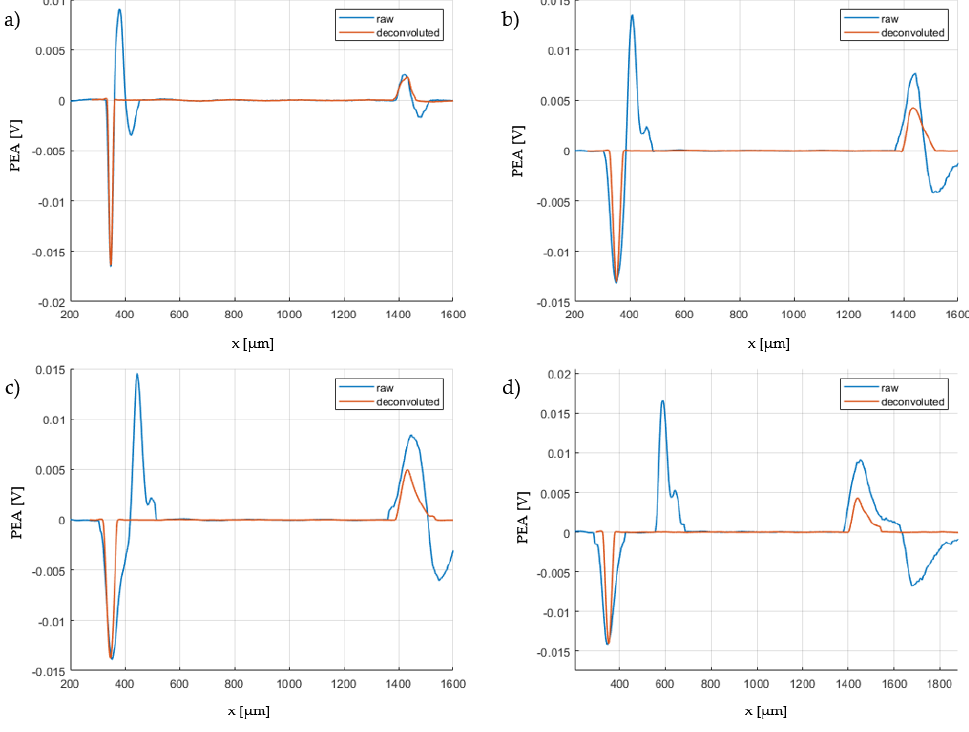
Figure 3. Space charge profile in LDPE d = 1 mm sample measured for different pulser widths t w and rise times t r , sensor d s = 9 µm, pulser ( a ) t w = 5 ns t r = 1 ns, ( b ) t w = 20 ns t r = 18 ns, ( c ) t w = 40 ns t r = 18 t r = 18 ns, ( d ) t w = 100 ns t r = 18 ns, HVDC U = 10 kV, signal raw and after